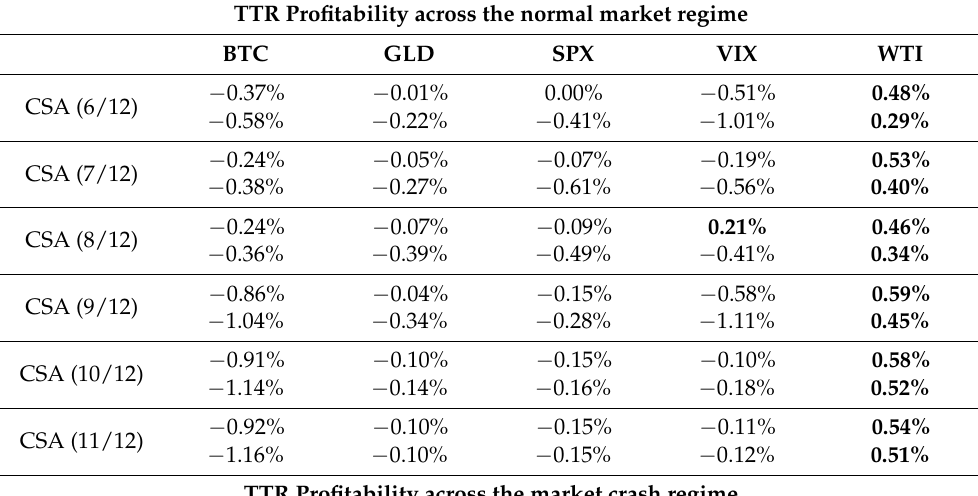
Table A4. CSA Strategy Profits across the COVID-19 Market Meltdown Market